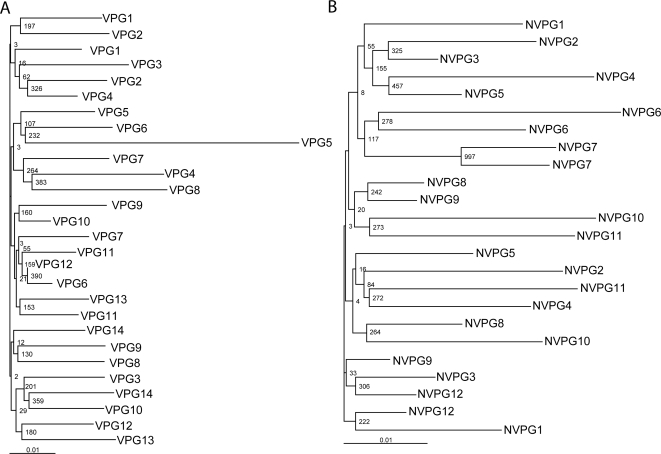
Phylogenetic analysis showed no evidence for systemic super-infection.No individuals studied in either the viremic partner group (A), or the non-viremic partner group (B) showed evidence of systemic super-infection by phylogenetic analysis. A unique partnership number indicates each partnership. No bootstrap values above 70% (indicated at each branch point) were generated between partner's viral sequences taken from the same time point, indicating their viruses were significantly divergent and no super-infection had occurred. * Known infecting partners.